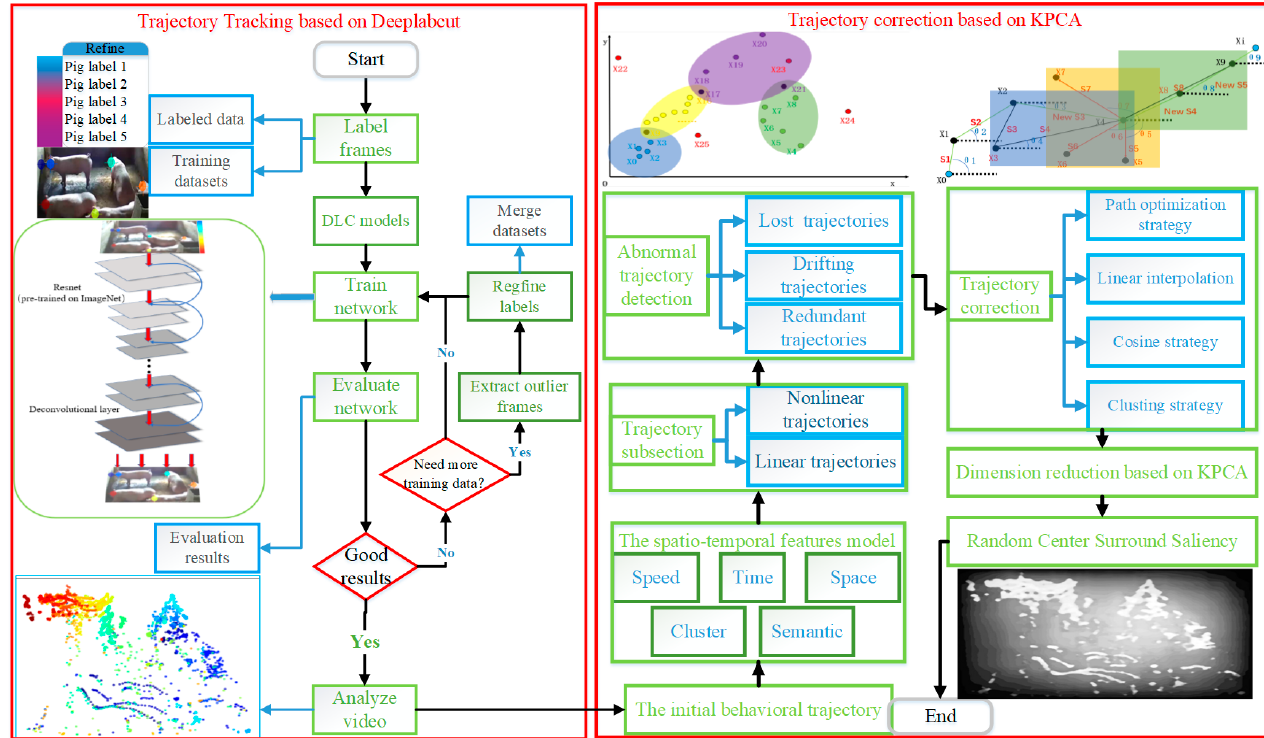
Figure 1. Method steps in this study.